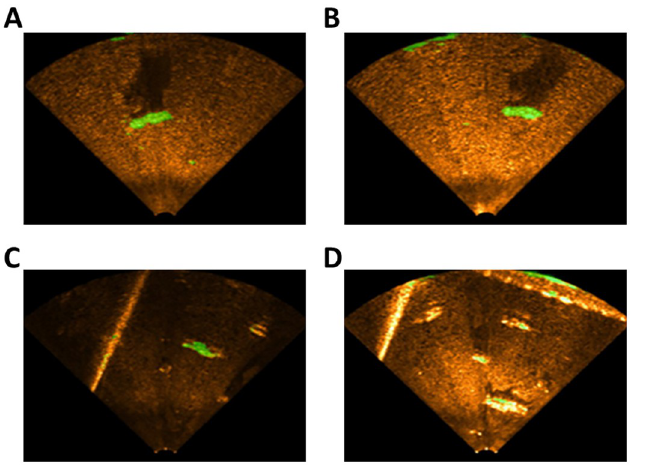
Fig 9. Results of segmenting a real USI with the USI NN trained using the synthetic USI created by the PLS_Synth model. (A) Reservoir low sensitivity, (B) Reservoir high sensitivity, (C) Pool low sensitivity, (D) Pool high sensitivity.